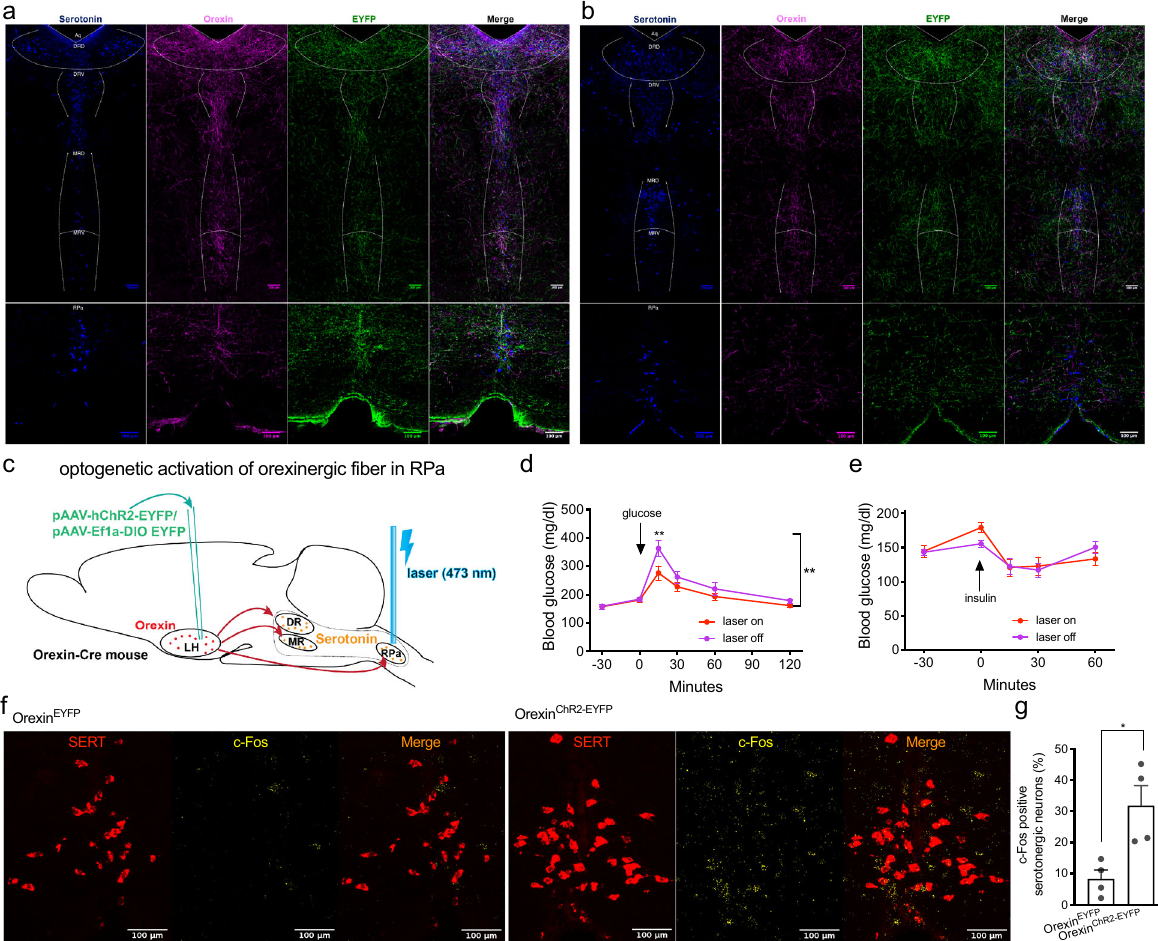
Fig. 9 Optogenetic stimulation of orexinergic fi bers in raphe pallidus (RPa) improves glucose tolerance. a Representative images of immunostaining of orexin and EYFP in DR/MR (upper panel) and RPa (lower panel) of Orexin-Cre mice injected with Cre-dependent adeno-associated virus pAAV-EYFP or b pAAV-ChR2-EYFP virus (Orexin ChR2-EYFP ). n = 3. Blue, serotonin; magenta, orexin; green, EYFP. c Schematic drawing of the strategy of optogenetic stimulation of orexinergic fi bers in RPa. d Glucose tolerance test and e insulin tolerance test of Orexin ChR2-EYFP mice with (laser on) or without (laser off) laser illumination in RPa. n = 8. d p = 0.0015 (15 min). f Representative images of RNAscope in situ hybridization of c-Fos and serotonin transporter (SERT) in raphe pallidus and g the quanti fi cation of percentages of c-Fos positive neurons in serotonergic neurons after laser illumination. n = 4. p = 0.015. Red, SERT; yellow, c-Fos. Scale bar: 100 µ m. Data are represented as means± SEM. * p < 0.05, ** p < 0.01; as determined by unpaired two-tailed Student ’ s t -test ( g ) or two-way ANOVA followed by Sidak ’ s post hoc test ( d ). Two-way ANOVA revealed a signi fi cant main effect of genotype in ( d ) ( F (1, 84) = 9.34, p = 0.0030). Source data are provided as a Source Data